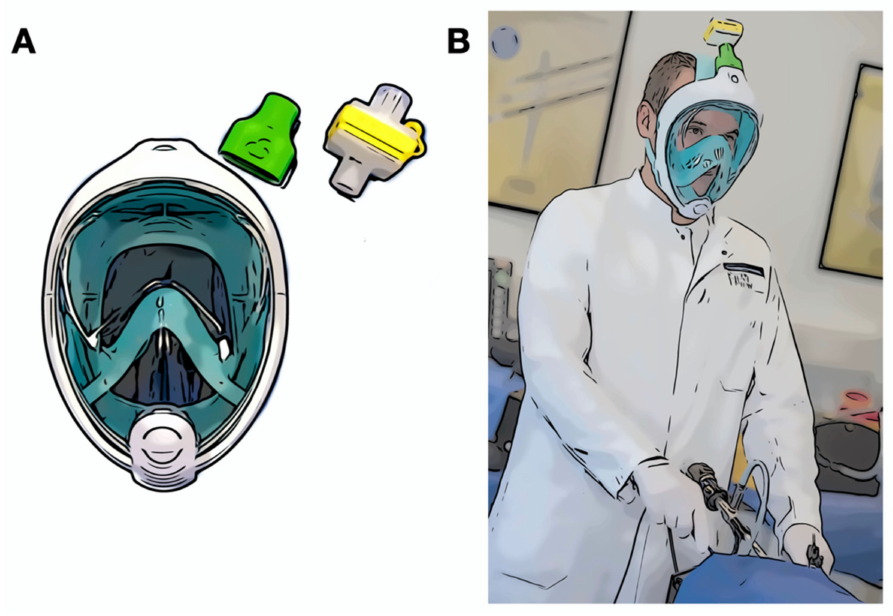
Figure 1. Schematic representation. ( A ) A full-face diving mask with a 3D-printed adapter (green) and air filter (yellow); ( B ) A